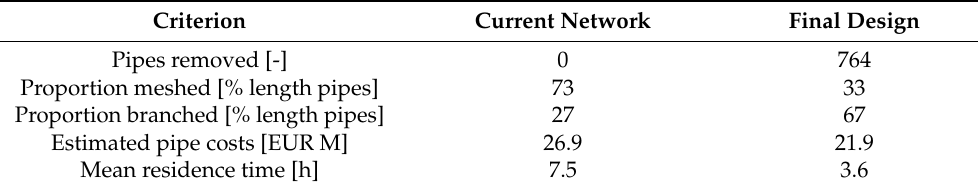
Table 3. Comparison of performance between the current network and the final